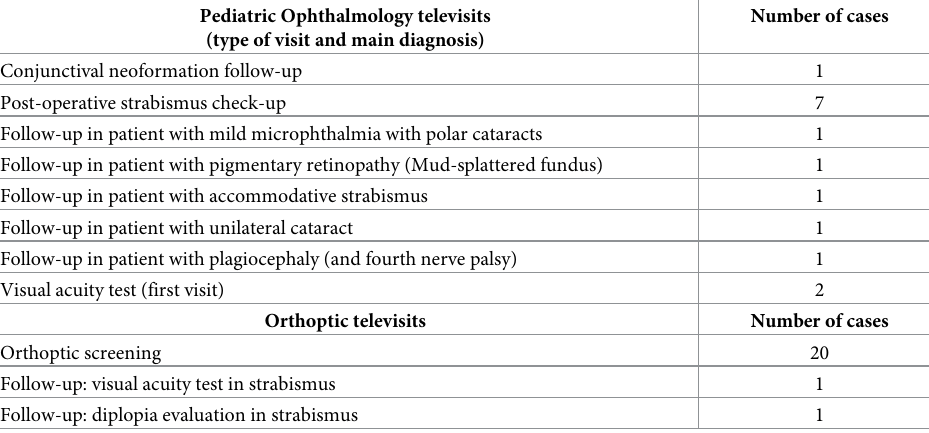
Table 2. General aim of